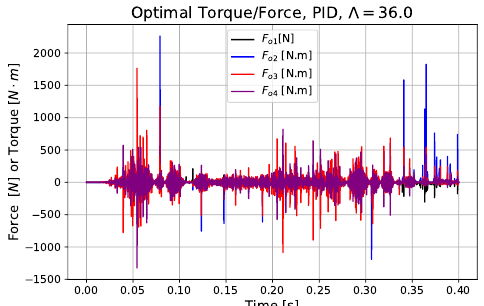
Figure 21. The adaptive abstract rotations ( a ) and the computational time-need of the main cycle without force limitation ( b ) for the increased α min = 0.1.